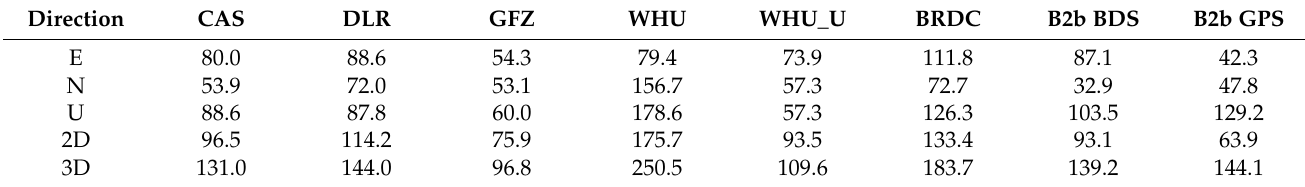
Table 9. Position RMSE of vehicle-borne real-time single-frequency PPP using different SSR products (unit: